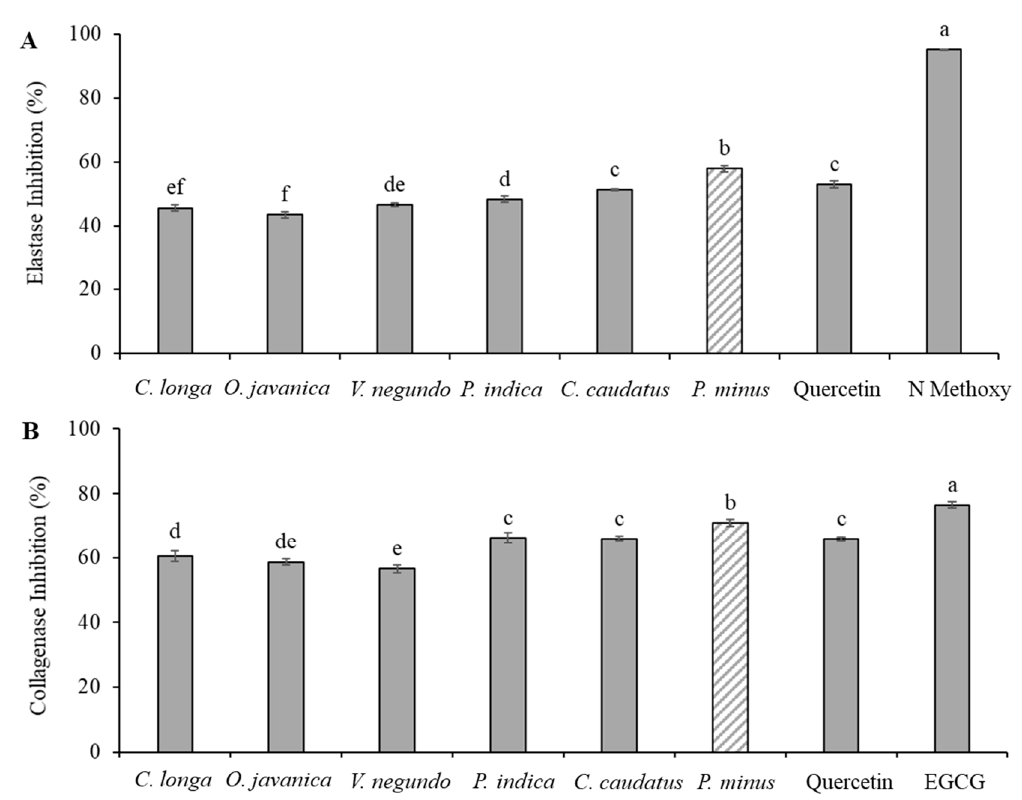
Figure 2. Inhibition of enzymes activity by selected herb extracts at 100 ug / mL. A : Elastase inhibitory activity, B : Collagenase inhibitory activity. Positive control N -Methoxysuccinyl-Ala-Ala-Pro-Chloro ( N Methoxy) and epigallocatechin gallate (EGCG) concentration at 12.5 ug / mL. Means with the same letters are not significantly different ( p > 0.05).